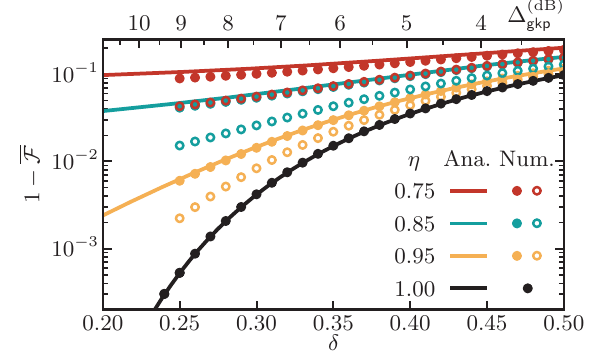
FIG. 10. Comparison of the average gate infidelity 1 − F of the telecorrection circuit in Fig. 9 in the absence of the loss and dephasing channel N , calculated through numerical Fock space simulations (filled circles) and through the twirling approximation (solid lines) as a function of the regularization ). We show results parameter δ = δ data = δ anci (squeezing (cid:17) ( dB ) gkp for unit-efficiency homodyne detection as well as finite